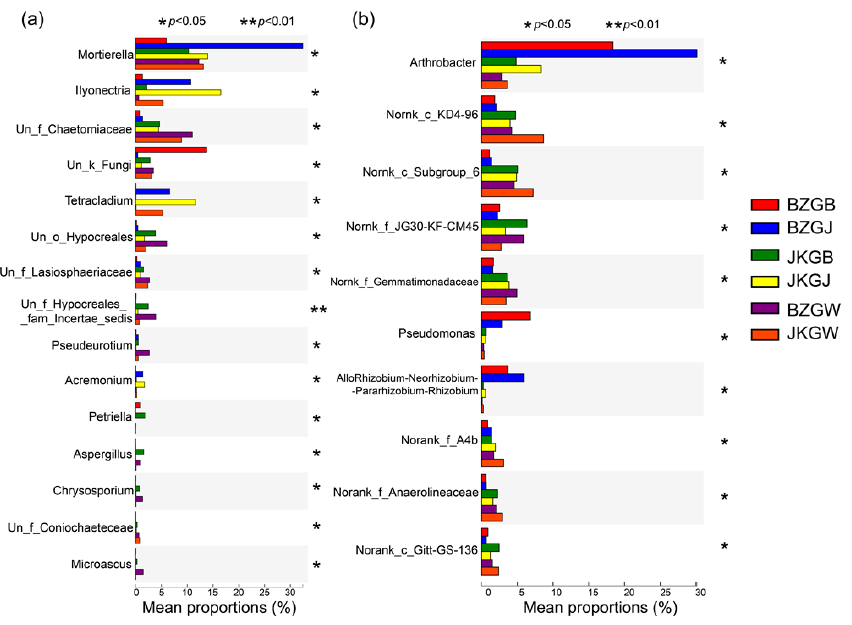
Figure 6. Kruskal–Wallis H test bar plot. Note: The Y-axis represents the species names at the genus level. The X-axis represents the average relative abundance in different groups, and the columns with different colors represent different groups. On the far right is the p -value, and “*” represents 0.01 < p ≤ 0.05. ( a ) Is the fungal community, and ( b ) is the bacterial community. BZGB denotes the rhizoplane diseased plants, JKGB denotes the rhizoplane healthy plants, BZGJ denotes the rhizosphere diseased plants, JKGJ denotes the rhizosphere healthy plants, BZGW denotes the root zone diseased plants, and JKGW denotes the root zone healthy plants.